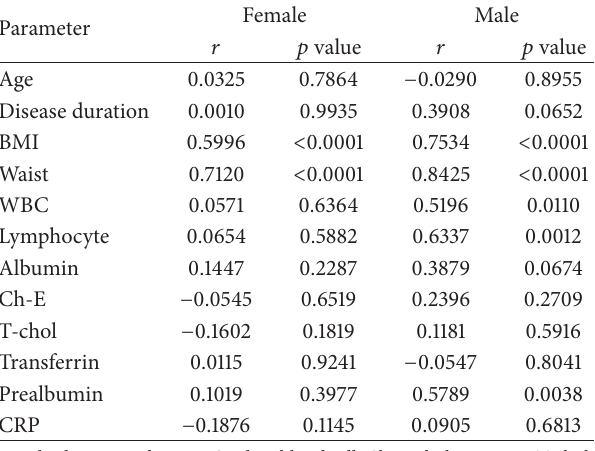
Table 3: Correlation analyses between visceral fat area and each parameter in patients with MAC lung disease.